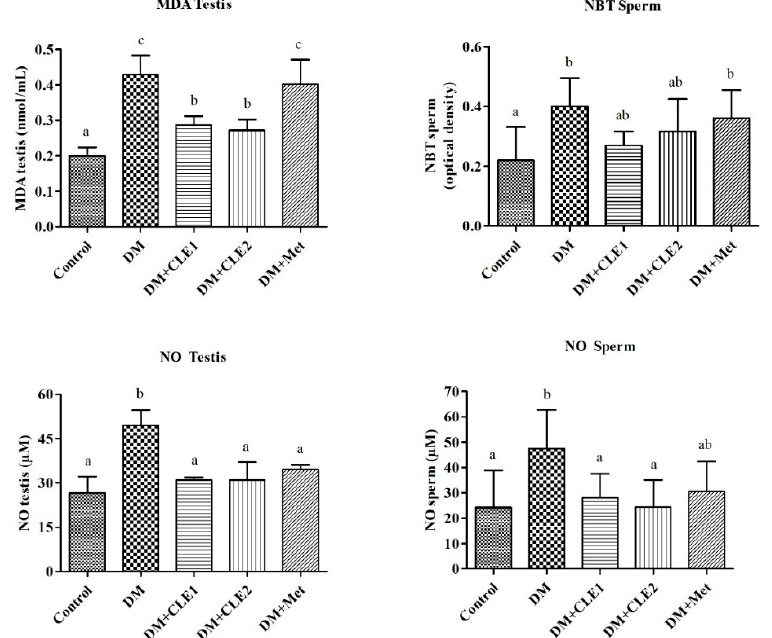
Figure 4 . The levels of MDA, NBT, and NO in the diabetic mice after treatment for 6 weeks. Data are shown as mean ± SD ( n = 5). The values with different letters (a–c) represent significant difference ( p < 0.05) as analyzed by a Duncan’s multiple range test. DM, diabetes; DM+CLE1, diabetes and 600 mg/kg of C. lentillifera ; DM+CLE2, diabetes and 1000 mg/kg of C. lentillifera ; DM+Met; diabetes and 200 mg/kg of metformin; MDA, malondialdehyde; NBT, nitro blue tetrazolium; NO, nitric oxide.